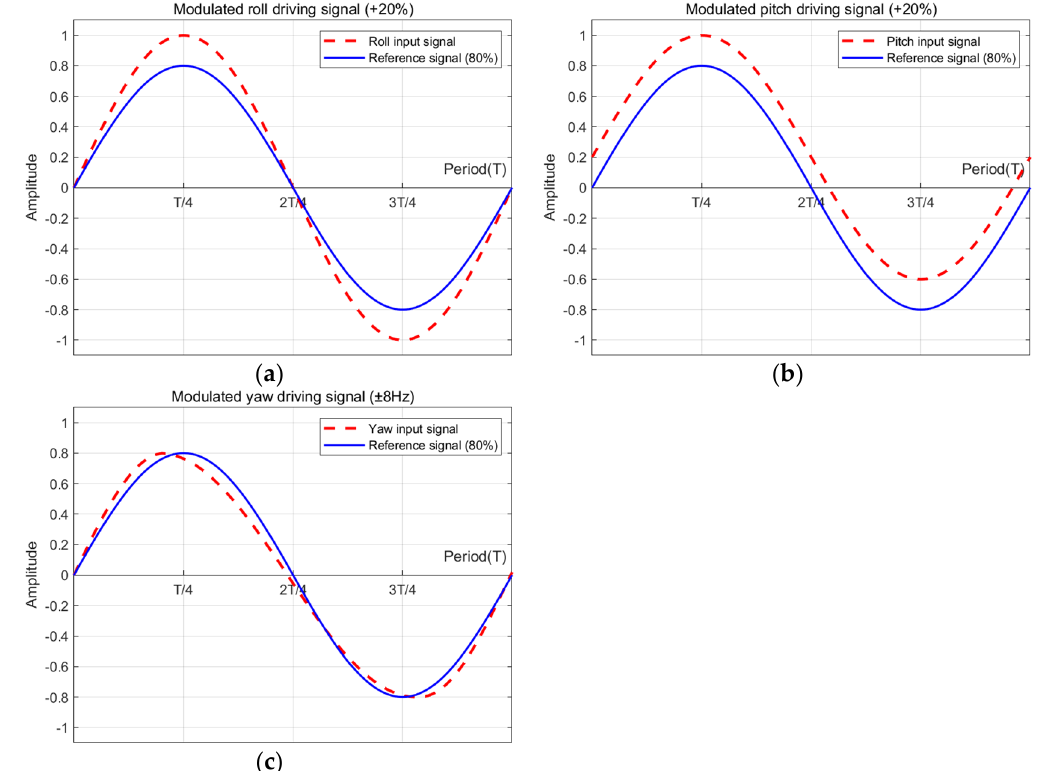
Figure 8. Driving signal waveforms for attitude controls: ( a ) roll control; ( b ) pitch control; ( c ) yaw control.